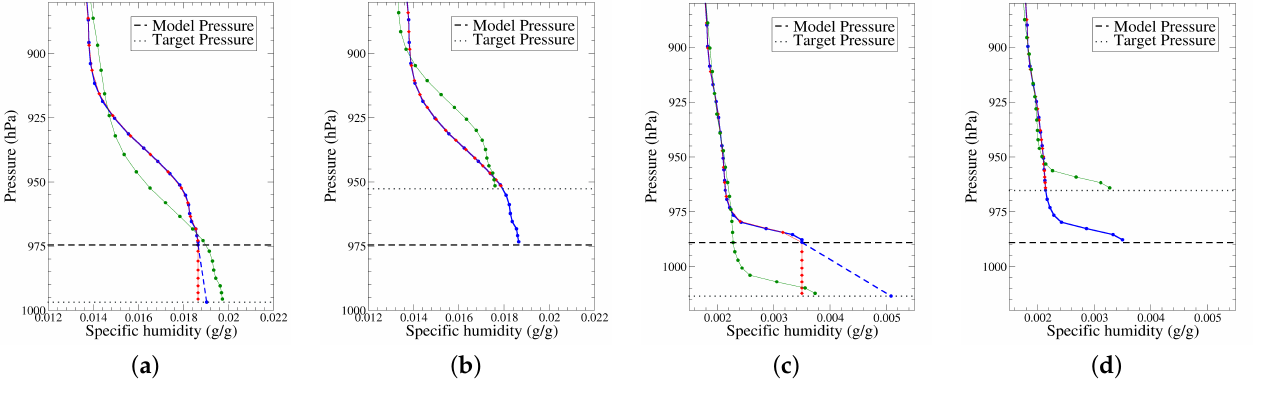
Figure 4. Humidity profiles provided by different extrapolations with last gradient in blue, standard (zero) gradient in red and APACHE method in green. The original profile defined only above the model topography corresponds to the blue points above the model ground pressure. Two examples: the first one over Africa, the second over the Alps. ( a , c ) with a target below the model topography, ( b , d ) with a target above the model